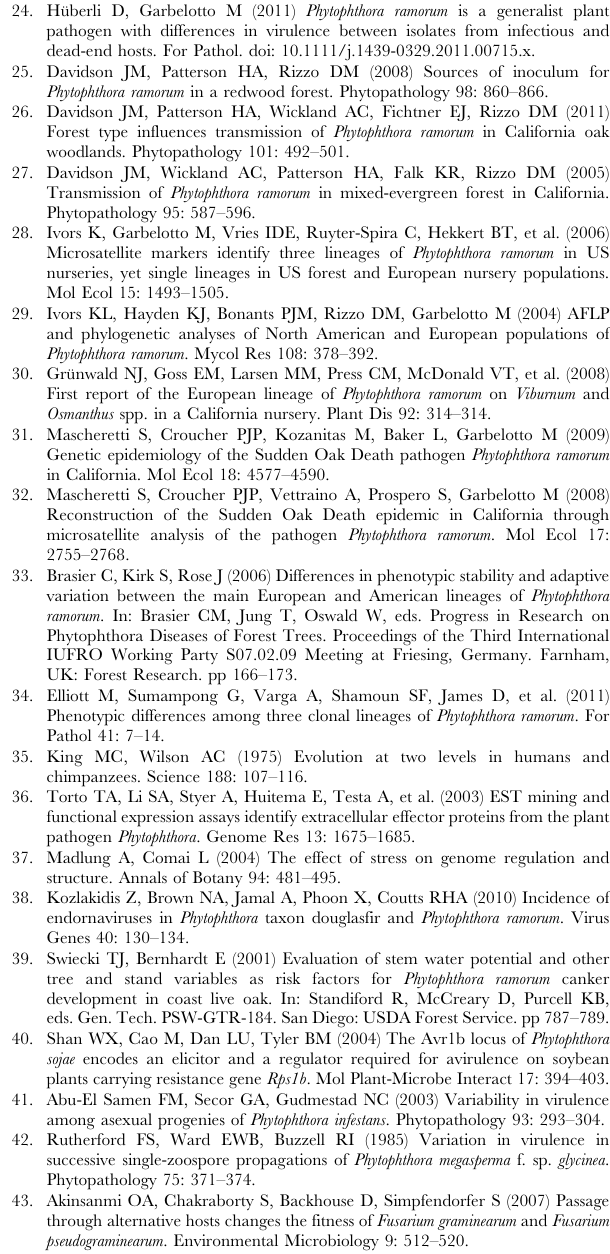
Table S5 Oligonucleotide primers used for qRT-PCR analysis of Californian isolates of Phytophthora ramorum . Dataset S1 This dataset provides mRNA profiling results and information for each gene such as functional annotation, GO terms, transposon class and expression clusters for 12,516 detected genes by means of Phytophthora ramorum NimbleGen expression microarray. Each of columns is explained in the attached worksheet